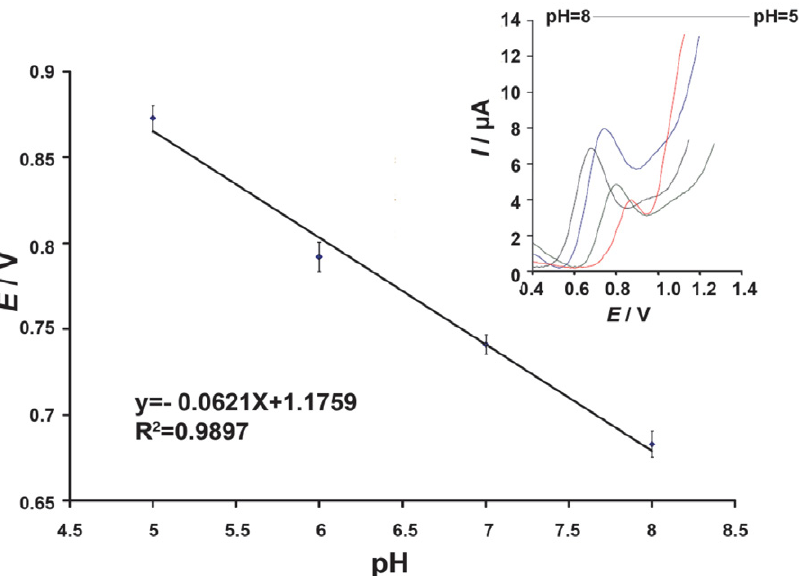
Figure 2. Plot of potential vs. pH for the electrooxidation of 100 µmol L −1 6-TG at CuO/1E3MIBF 4 /CPE. Inset: Linear sweep voltammograms of 100 µmol L −1 6-TG with different pHs (scan rate = 100 mV s −1 ).